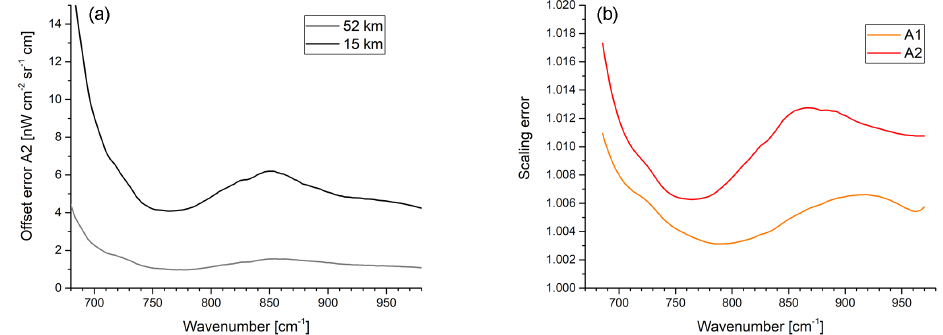
Figure 10. (a) Estimated offset error for A2 due to the neglect of the cubic artifact for a tangent altitude of 15km (black) and 52km (gray). (b) Estimated gain error due to the neglect of the cubic artifact in the blackbody and deep space spectra for channel A1 (orange) and A2 (red) for orbit 1680 at the beginning of the